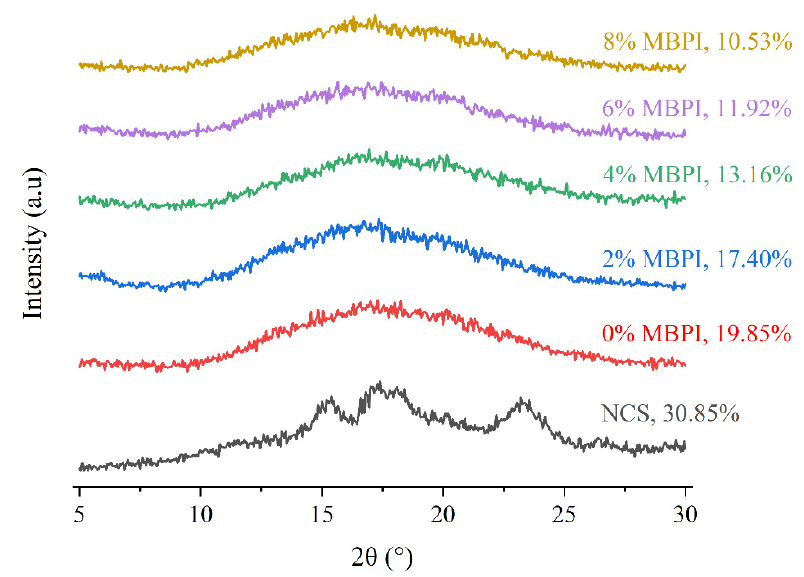
Figure 3. XRD pattern and RC of NCS and freeze-dried NCS/MBPI gels at different MBPI concentrates.